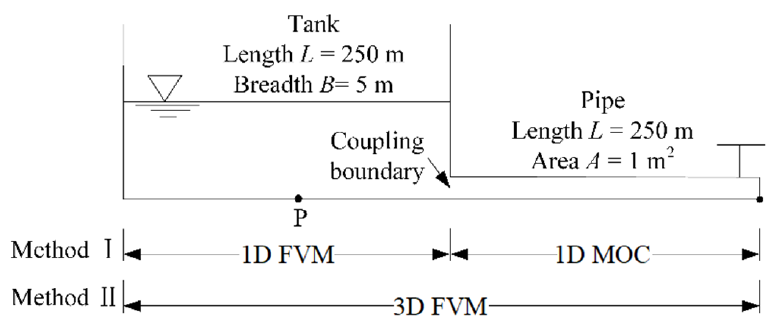
Figure 4. Schematic of the tank ‐ pipe system. Two methods were applied to simulate this tank-pipe case. The first method (Method I) is the proposed MOC-FVM coupling method. The time step in the simulation is 0.005 s and the spatial step is 5 m for the 1D meshes. The 3D FVM method (Method II) is